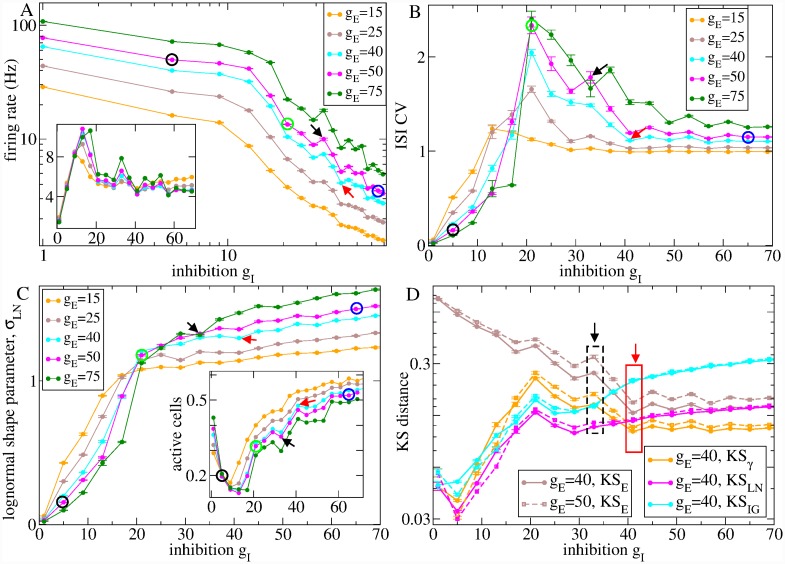
2500 cell network model shows transition as parameters are varied.Several quantities calculated from 200 second network simulations divided into 5, 40 second long, non-overlapping segments. Quantities shown (except c, inset) are calculated from single unit spike trains averaged across all active cells in each 40 second segment. Bars show SEM in these averages across the 5 segments. Results are versus inhibition, gI, at several levels of excitation, gE (see keys). Simulations at different levels of inhibition, gI, are different realizations of random networks with given connection probability of 0.2. Simulations at any given level of inhibition are identical except for the different levels of excitation, gE. (a) mean firing rate, r, (a, inset) rescaled mean firing rate, r(gI/gE), (b) mean ISI CV, (c) maximum likelihood lognormal distribution shape parameter, σLN, (c inset) number of active cells (which fire at least one spike in the whole 200 second network simulation period), (d) KS distance between the model generated ISI distribution and the estimated maximum likelihood exponential distribution (KSE, brown), γ distribution (KSγ, orange), lognormal distribution (KSLN, pink) and inverse gaussian distribution (KSIG, cyan) for two different values of gE (gE = 40, solid and gE = 50, dashed). (a-c) Black, red, green and blue circles indicate the simulations described in Fig 5. (a-d) Black (WT) and red (HD) arrows (and boxes in (d)) indicate the two individual network simulations which are best-fit for two particular restricted age experimental datasets, denoted ‘WT75’ and ‘HD12’. The ISI statistics for these two simulations and the two corresponding experimental datasets are shown in Figs 8 and 9.